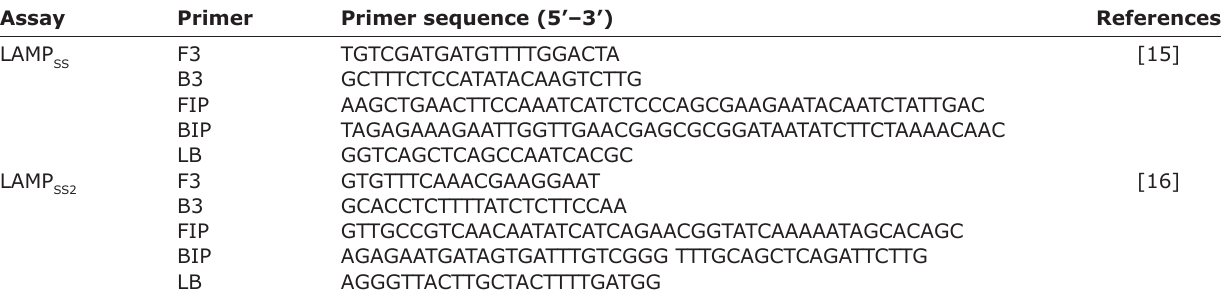
and LAMP used in this study. SS SS2